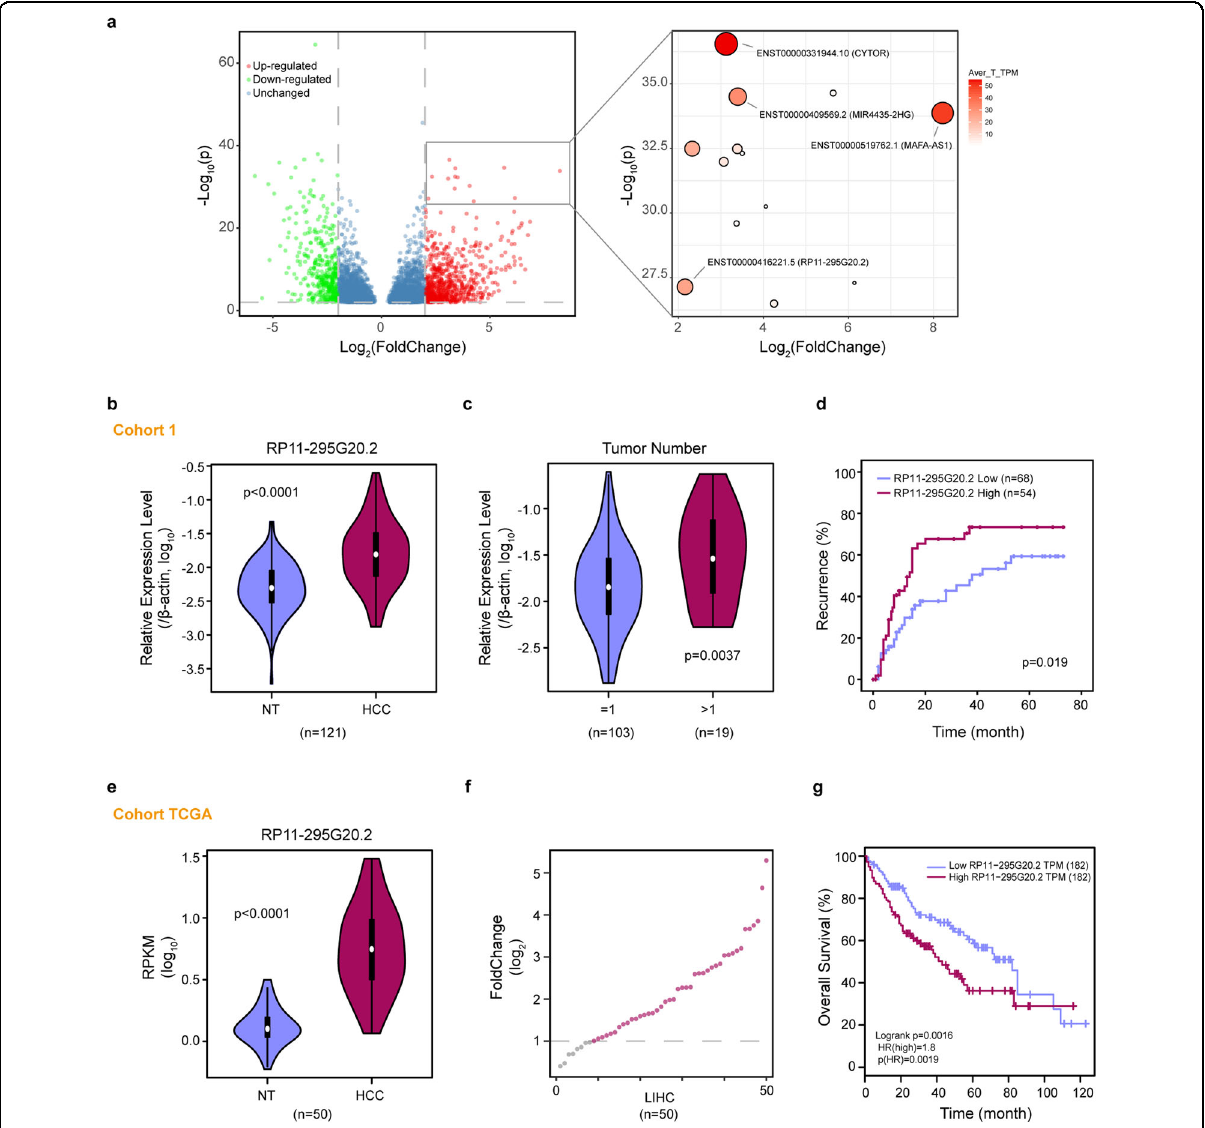
c RP11-295G20.2 is highly expressed in HCC patients with more than one tumor in HCC cohort 1. d HCC patients with higher RP11-295G20.2 levels are prone to relapse. e , f RP11-295G20.2 is upregulated in TCGA HCC samples. g HCC patients with higher RP11-295G20.2 show worse overall survival outcomes. * P < 0.05, ** P < 0.01, and *** P <